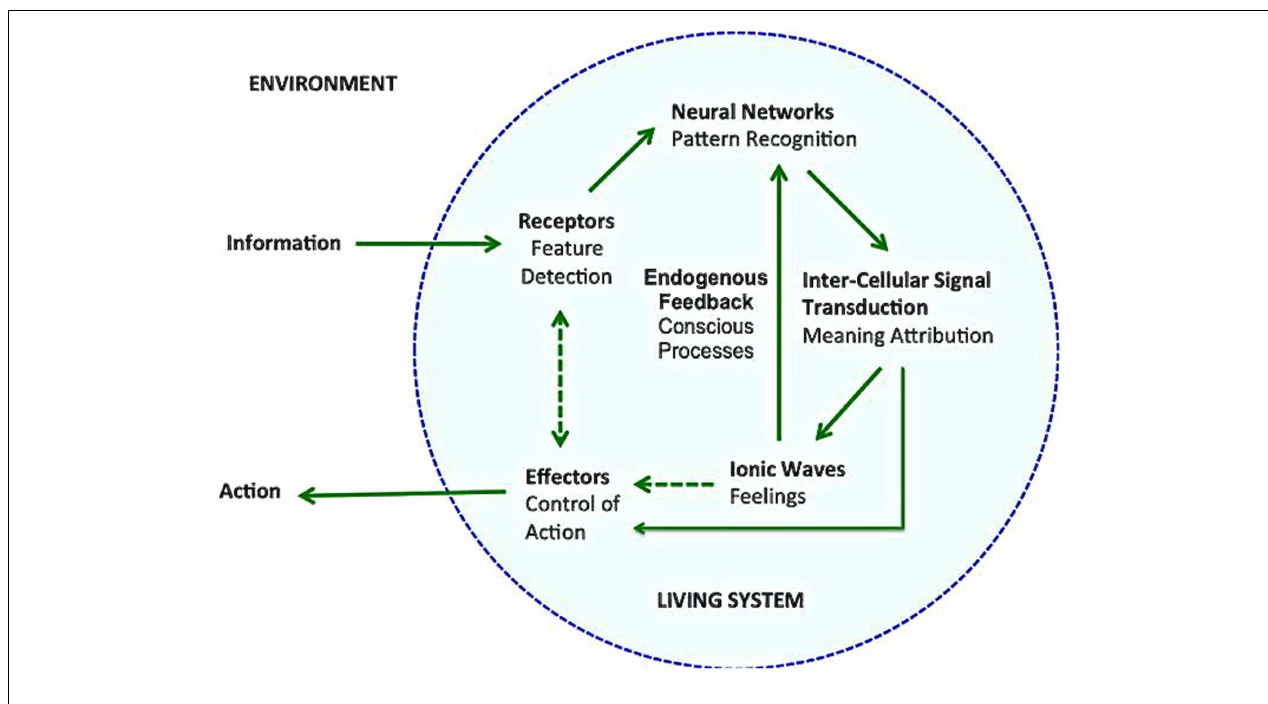
attribution, influencing the effectors. In the third mode, the attributed meaning triggers the formation of astroglial calcium waves, corresponding to the instantiation of feelings, which feed back positively or negatively on the pattern recognition process, forming an endogenous feedback cycle that also exerts an influence on the action